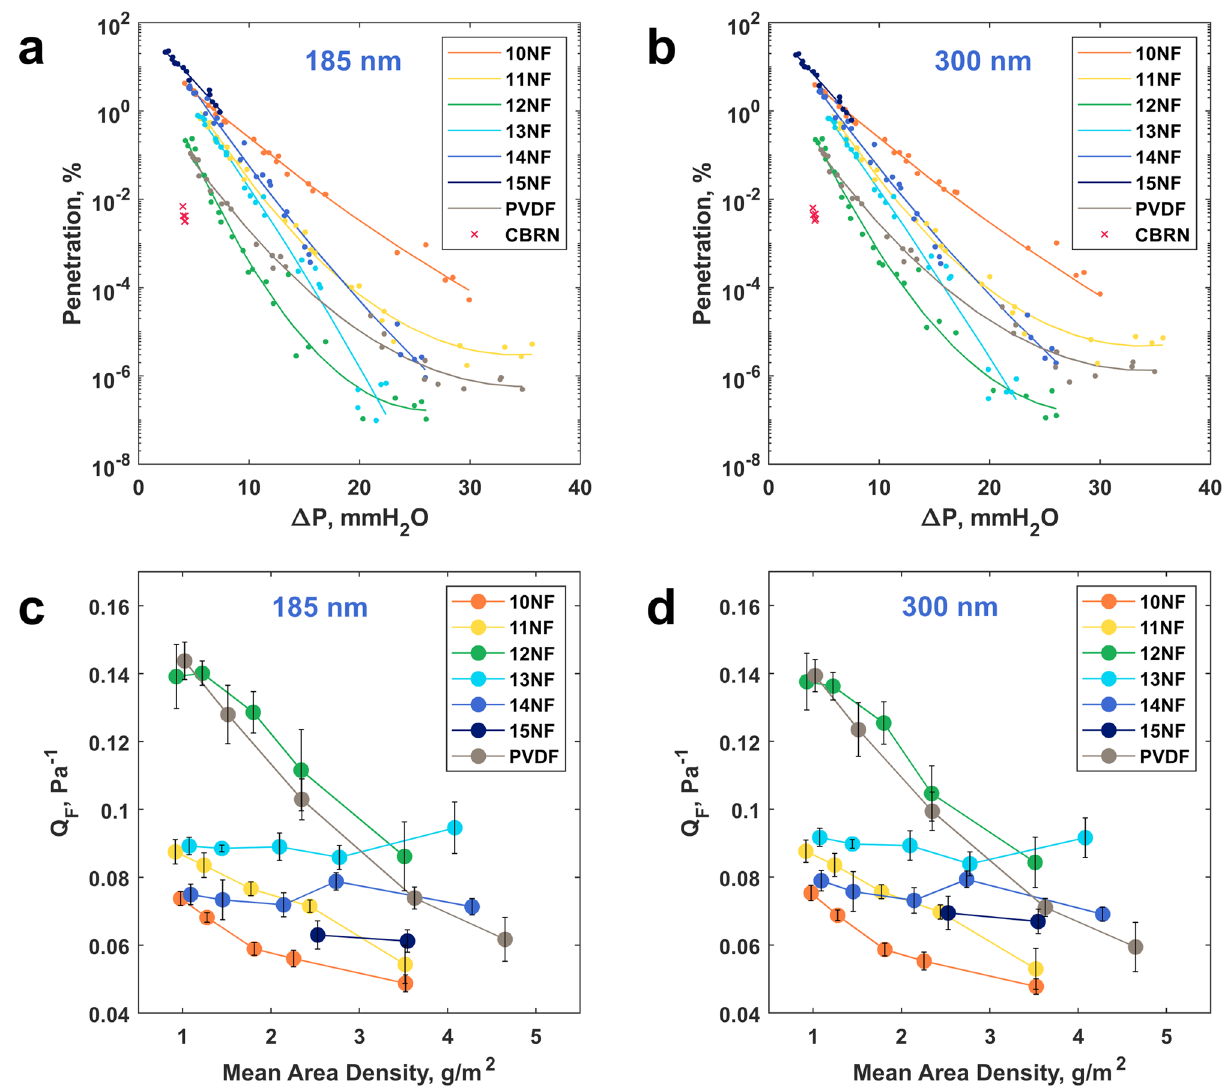
Figure 3. Filtration performance of the electrospun nanofibrous filters: ( a,b ) scatter plots for measured aerosol penetration and corresponding pressure drops of filter material samples fitted with second-order polynomial curves; ( c,d ) quality factors of nanofibrous filters with various average area densities corresponding to different substrate speeds with error bars representing the standard